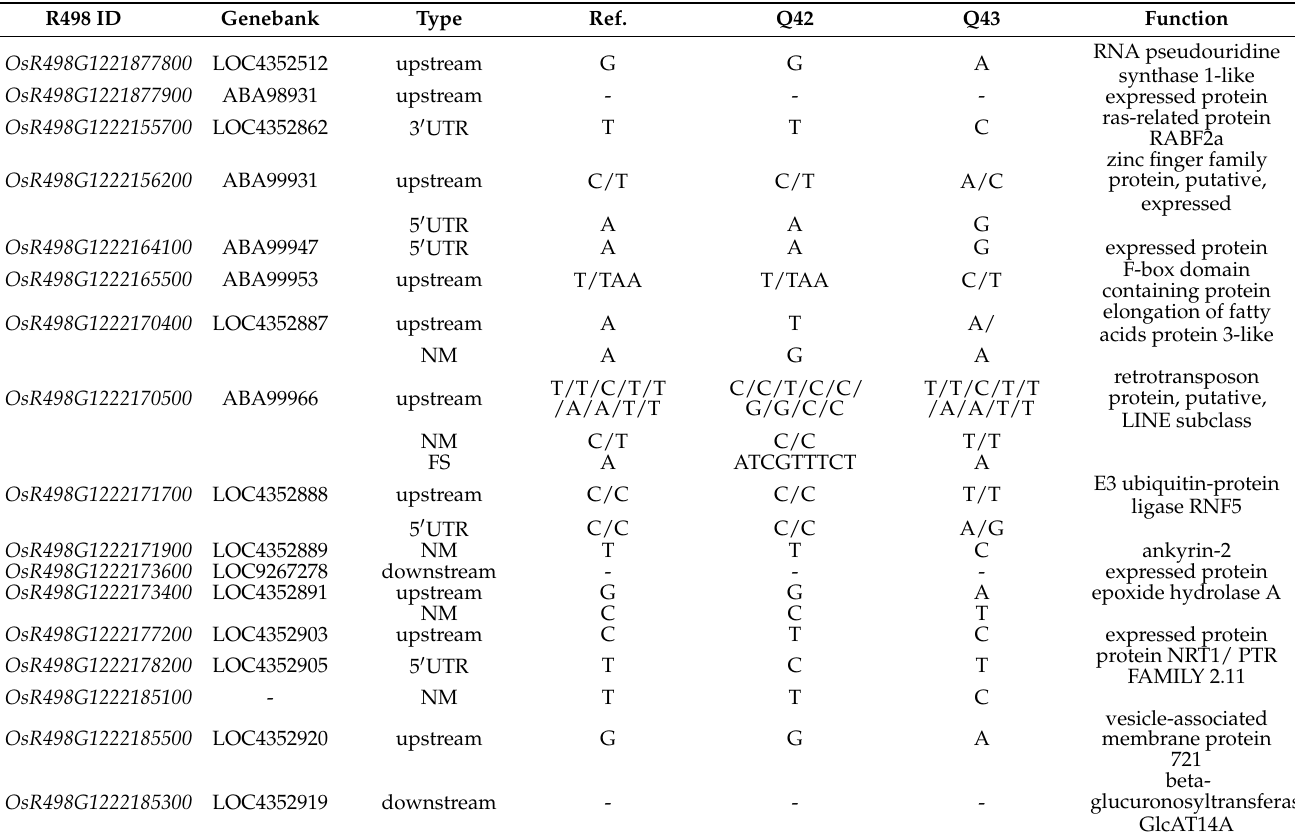
upstream downstream - - -